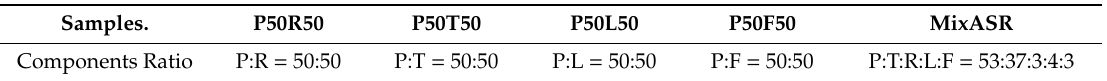
Table 2. The constituents of mixed